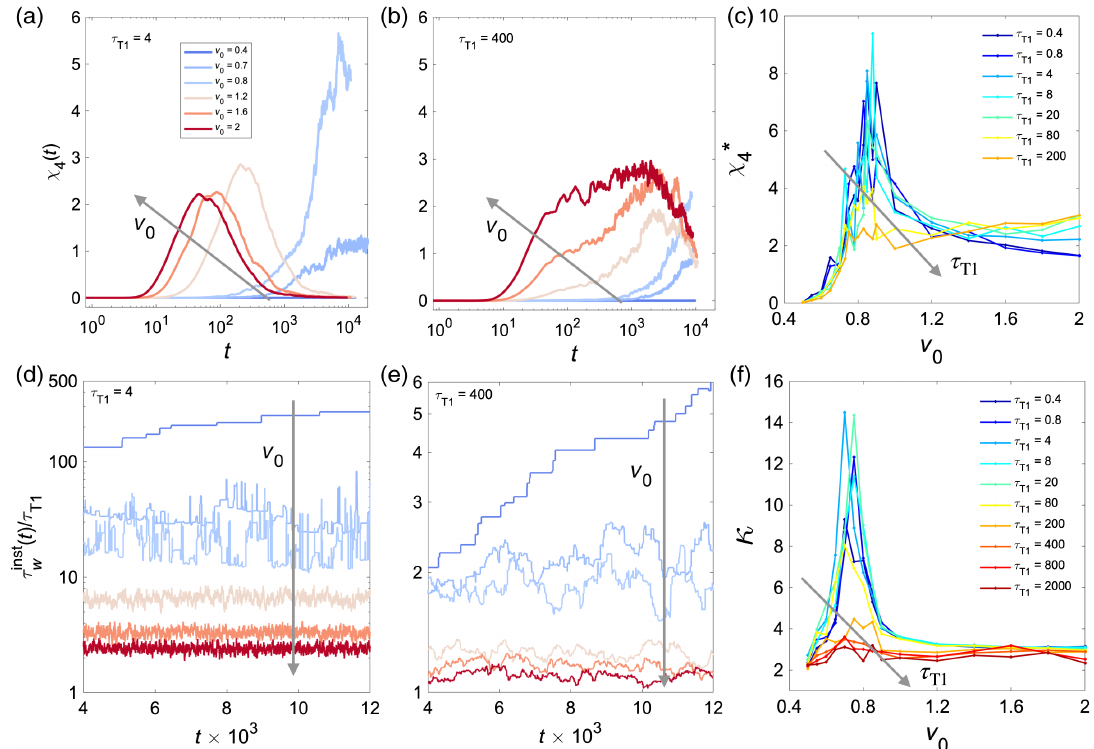
FIG. 2. Persistence in T1 events introduces variable degrees of dynamic heterogeneity and drives intermittency of rearrangements. (a), (b) Four-point susceptibility χ 4 ð t Þ for different v 0 at two different τ . (c) Peak value of χ 4 denoted as χ (cid:3) 4 vs v 0 . (d),(e) Time series of the T 1 instantaneous average of the waiting times of all cells, given by ¯ τ inst w ð t Þ , for the parameters corresponding to (a) and (b). (f) The kurtosis κ of the observed values of ¯ τ inst w , as a function of v 0